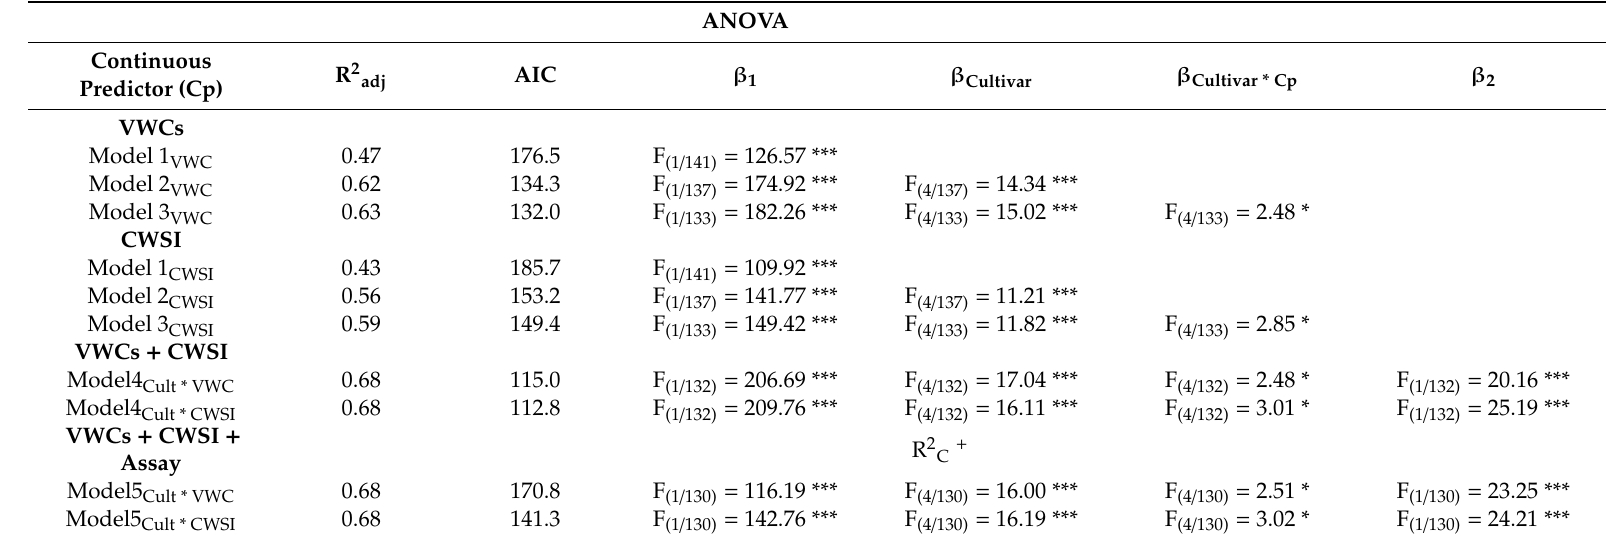
Table 4. Adjusted R squared (R 2 adj ), Akaike information criterion (AIC), and ANOVA results for the fixed variables on each model.